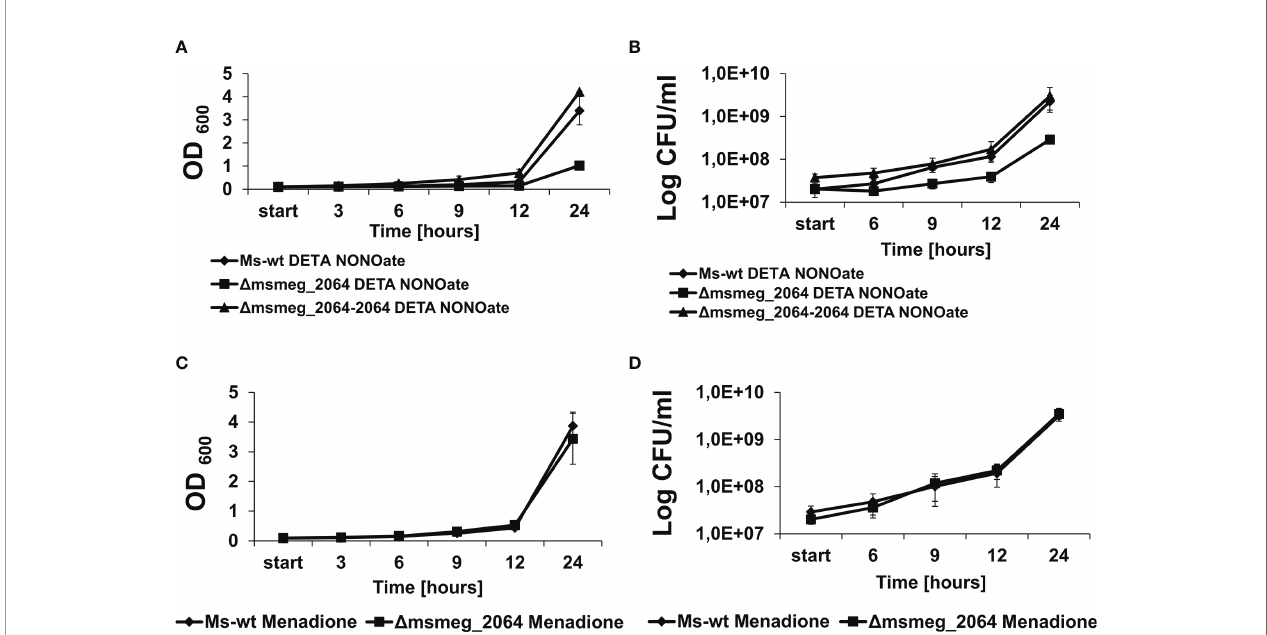
FIGURE 5 | Kinetics of growth and viability of Mycobacterium smegmatis strains treated with DETA NONOate or menadione. The mutant D msmeg_2064 , wild-type Ms-wt, and complementing D msmeg_2064 – 2064 strains were grown in 7H9 Middlebrook-rich medium in the presence of reactive nitrogen (DETA NONOate) (A, B) and oxygen species (menadione) (C, D) . The growth of strains was evaluated by measuring the OD 600 at the indicated time points (A, C) , and the numbers of viable cells were determined as bacterial colony-forming units (CFU) per ml on 7H10/OADC plates (B, D) . Means ± SDs are shown from three independent